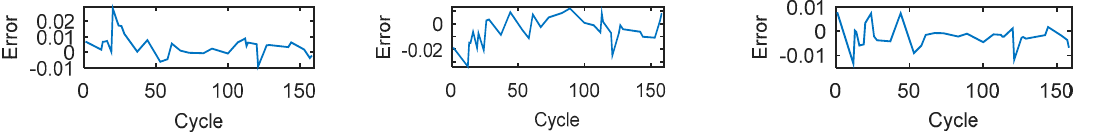
Figure 9. The SOH estimation error of the LS-SVM model with the RBF kernel tested on the No.5, No.6 and No.7 batteries.